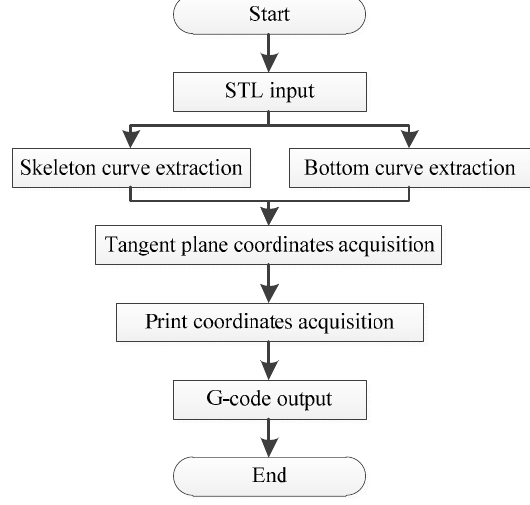
Figure 5. The path planning algorithm flow for axial printing.